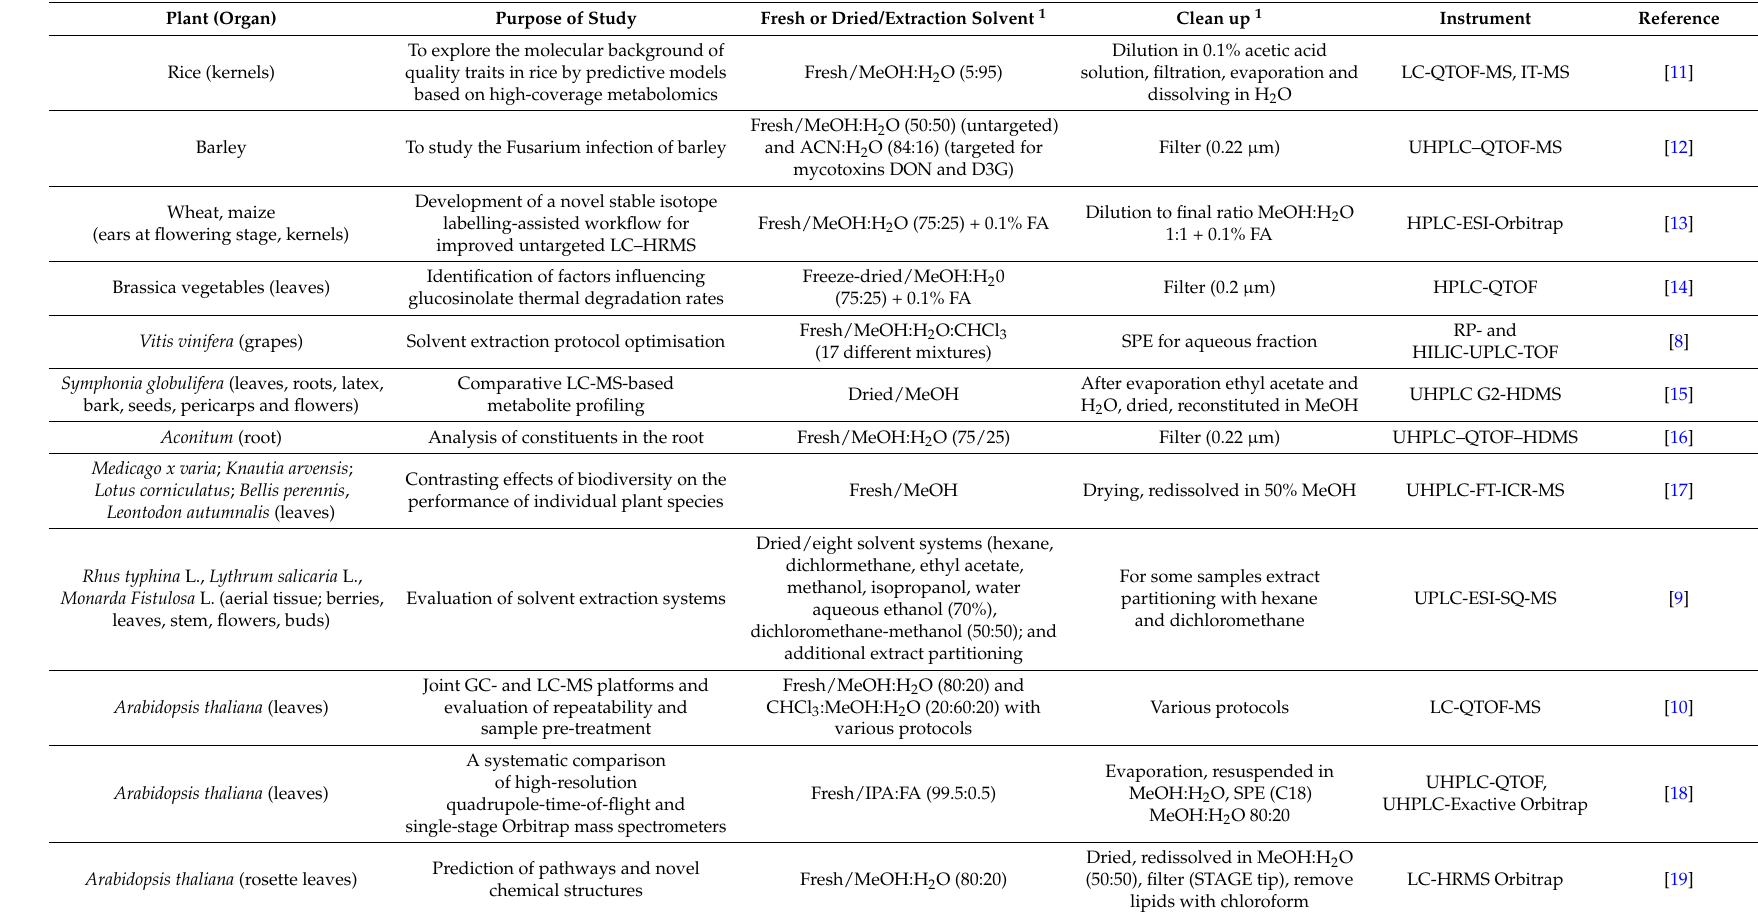
Table 1. Overview of selected untargeted LC-MS-based plant metabolomics